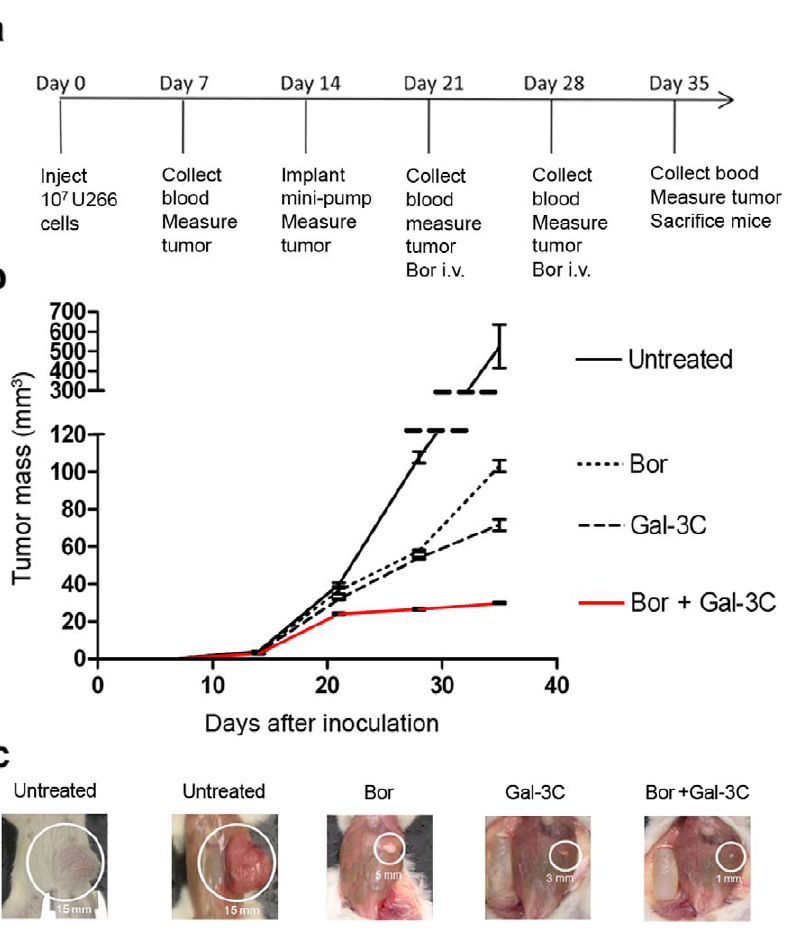
Figure 7. Experimental design and outcome of Gal-3C treatment in NOD/SCID MM xenografts. ( a ) The diagram shows the timing of tumor challenge, drug administration, and sample collections. ( b ) Gal-3C reduced the growth of U266 MM tumors as a single agent, and in combination with Bor significantly reduced the MM tumor growth compared to treatment with either agent alone. The primary tumors were measured weekly with calipers after subcutaneous inoculation of mice with U266 cells. The results represent the combination of 3 separate experiments with n=5 mice per group in each experiment, and the error bars represent 6 SEM. The mean tumor volume in the Bor-treated group was significantly less than in the untreated group from d 28 through d 35 (unpaired t test P , 0.001). The mean tumor volume in the group treated with Gal-3C alone also was significantly less than that in the group treated with Bor alone from d 21 through 35 (unpaired t test P , 0.001). At d 35, the mean tumor volumes of the Gal-3C-only and the Bor-only group were 13.5% and 19.6% that of the untreated controls, respectively. ( c ) Representative images are presented illustrating the difference between the groups in tumor size after 35 d.